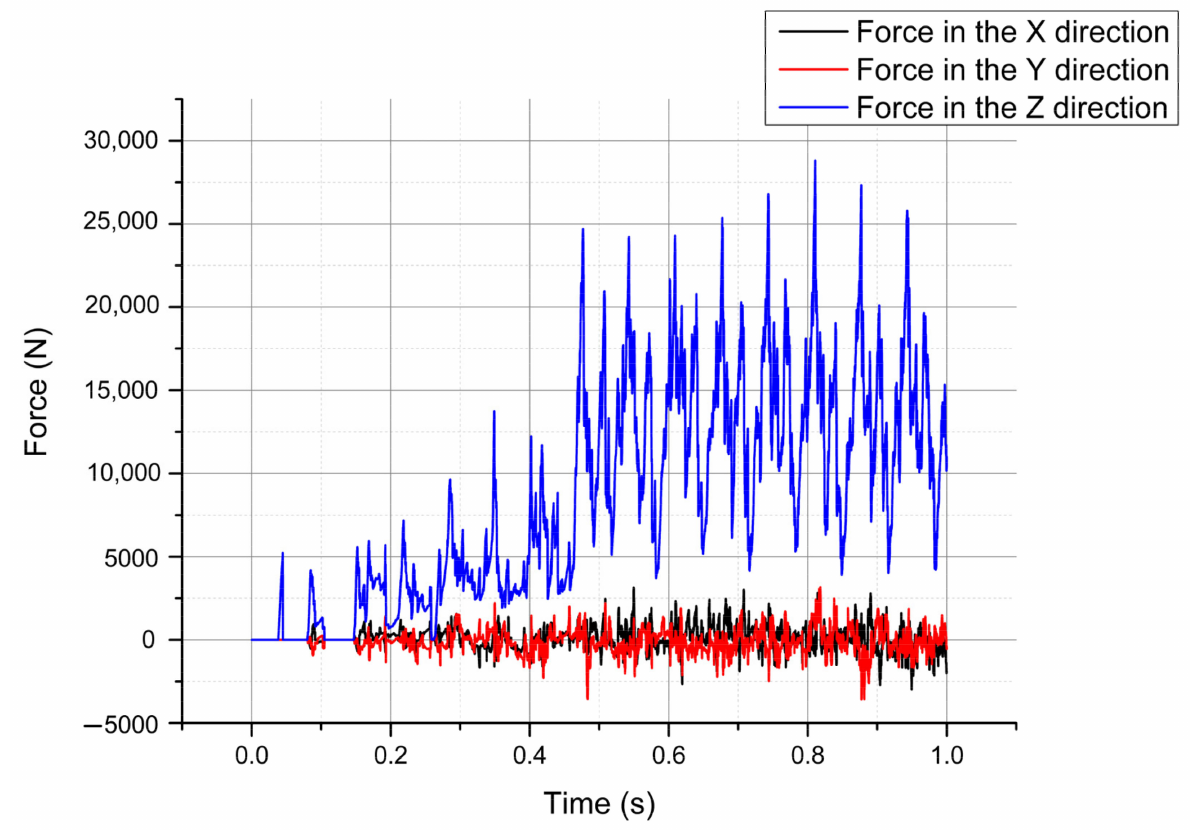
Figure 6. Three forces applied to the drill